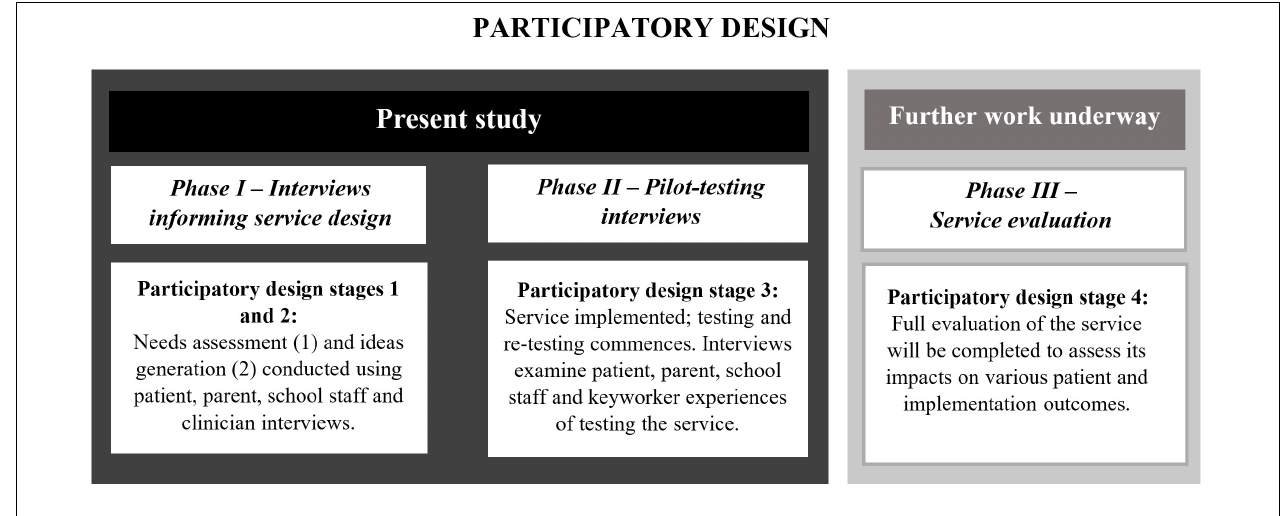
FIGURE 1 | Participatory design (PD) elements encompassed by each study phase.